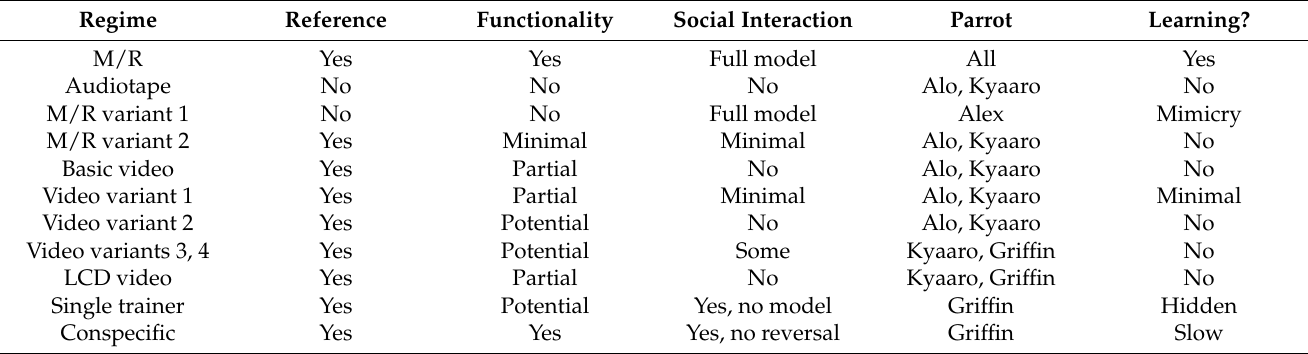
Table 1. Components and results of various types of tutoring